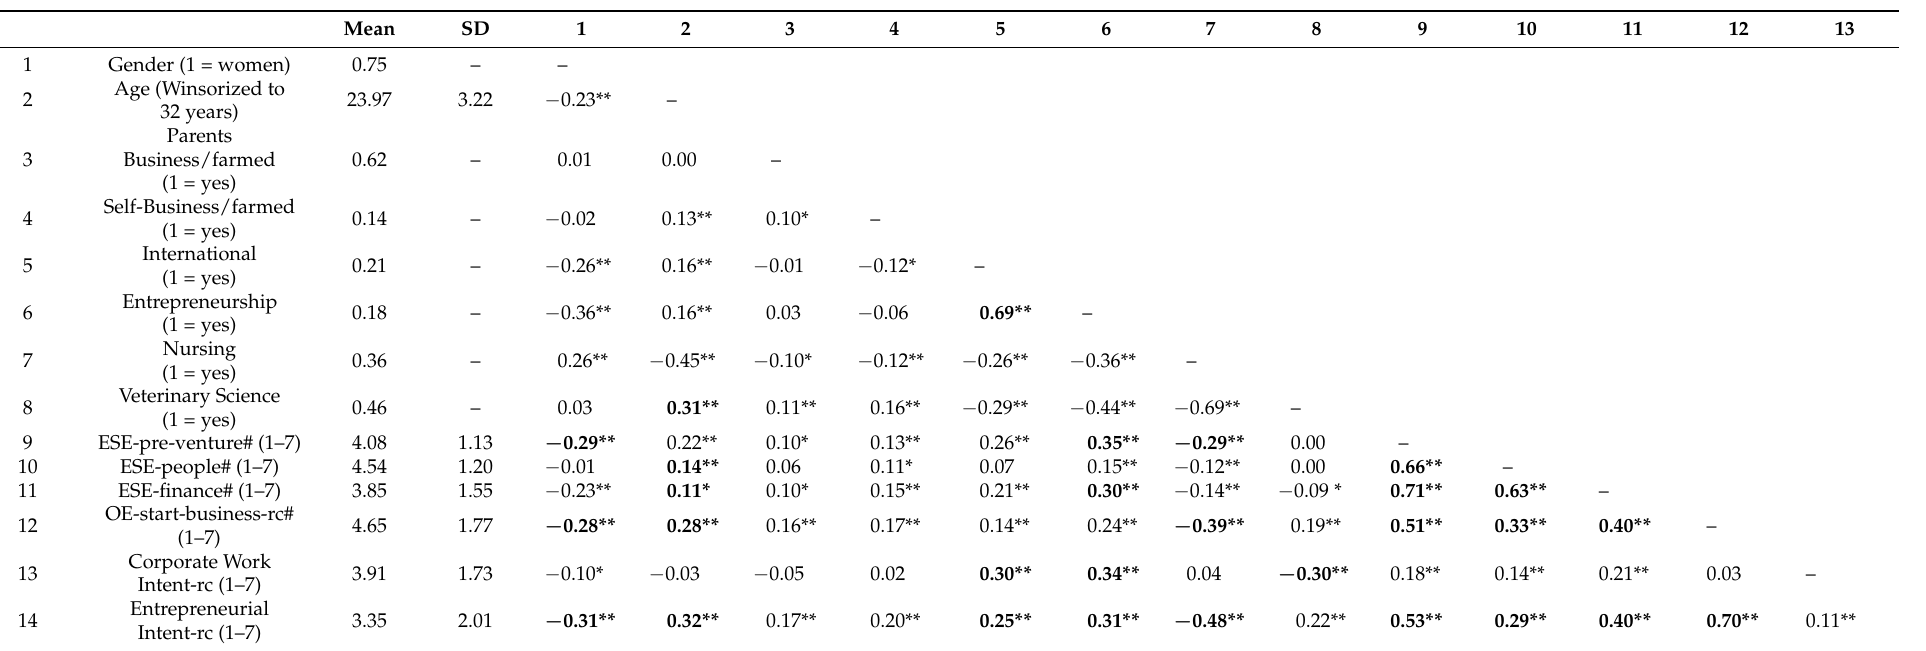
Table 3. Correlations (Spearman’s Rho) of demographic, self-report single items and composite factor scores (n = 515). (Significant correlations ≥ 0.3 in